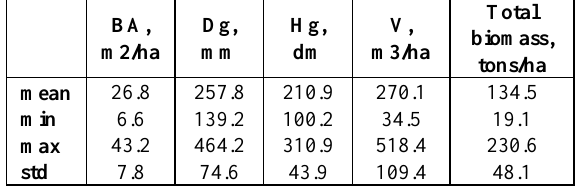
Table 1. Statistics of the forest plots used in the study. BA=Basal Area, Dg=mean diameter at breast height, Hg=mean tree height, V=stem volume.